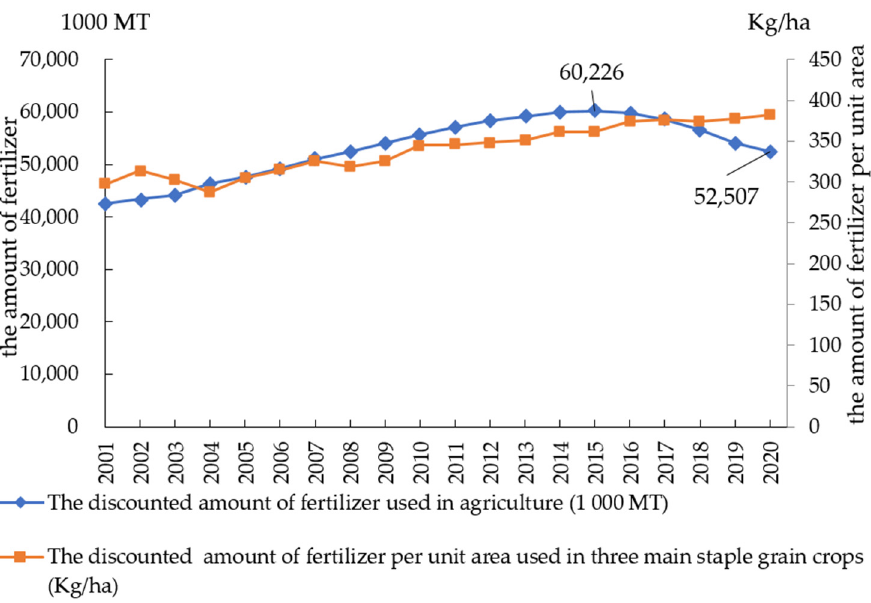
Figure 1. The total amount of fertilizer used in agriculture and that used in the three main staple grain crops.